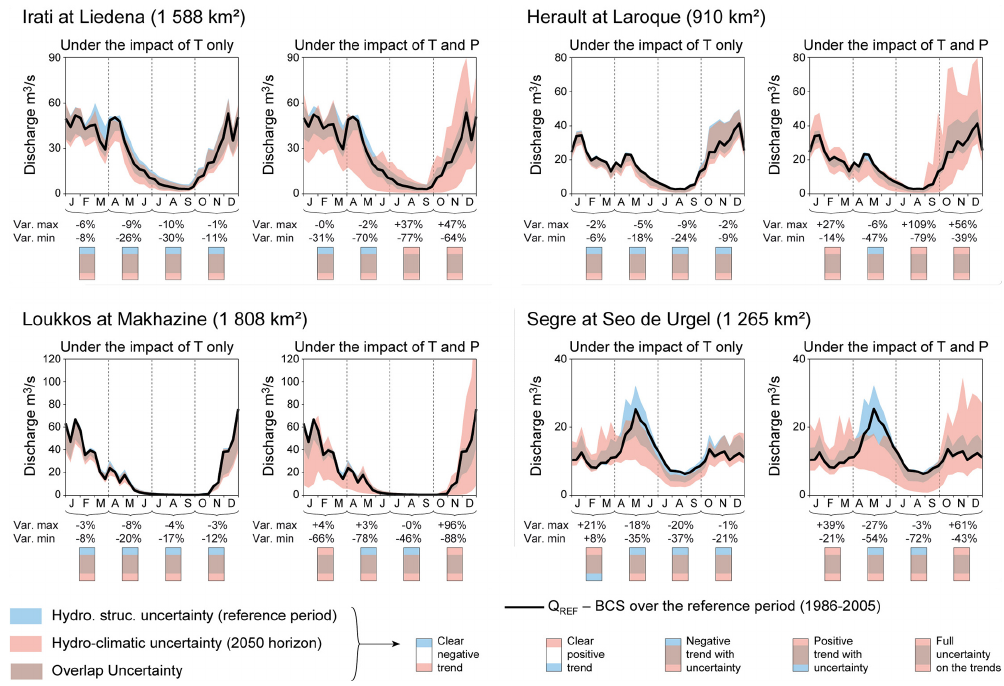
Figure 4. Hydrological scenarios by the 2050 horizon and associated